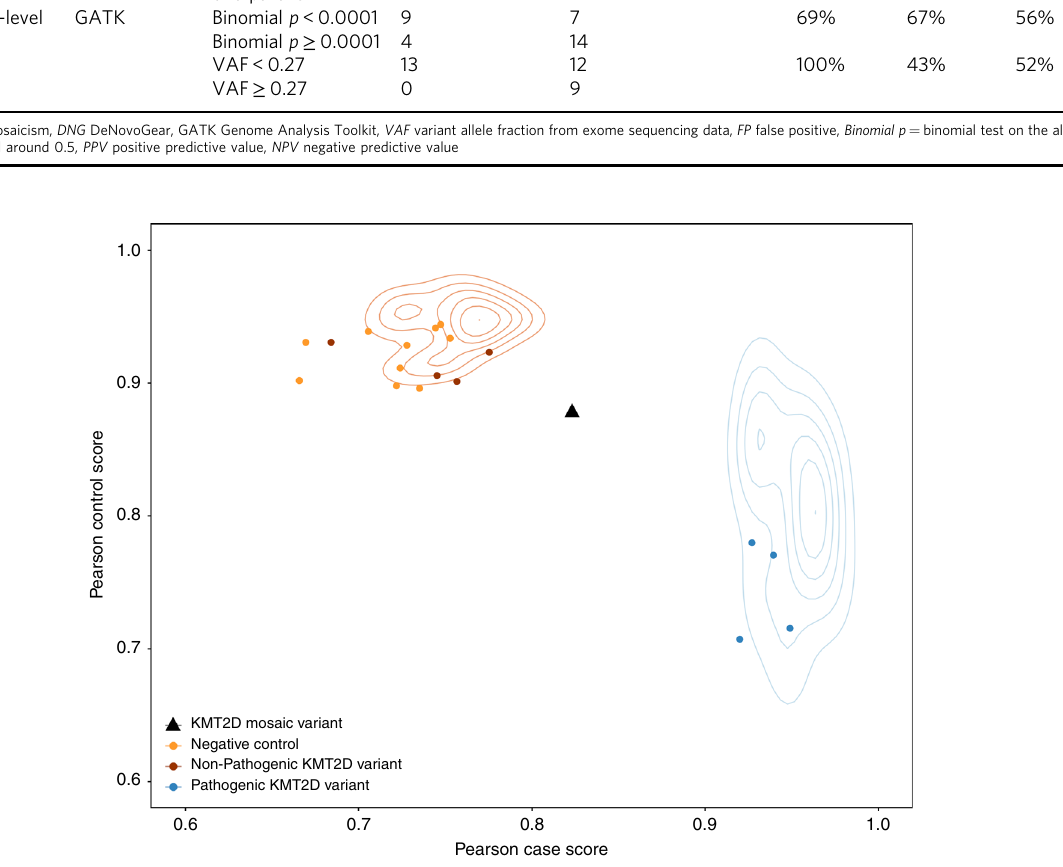
Fig. 5 Mosaic DDD proband with an intermediate methylation pro fi le. We evaluated DNA methylation at ~850,000 CpG sites across the genome in a subset of individuals from the DDD study using an Illumina EPIC methylation array. The blue cloud represents the distribution of published pathogenic KMT2D variants ( n = 12), and the orange cloud non-pathogenic KMT2D variants ( n = 15) from the published test set 44 . The points in red, orange, and blue represent methylation pro fi led non-mosaic KMT2D cases and negative controls from the DDD study; one DDD proband with a mosaic KMT2D stop-gain DNM (black triangle, VAF = 0.33) failed to classify as a case and sits between the two